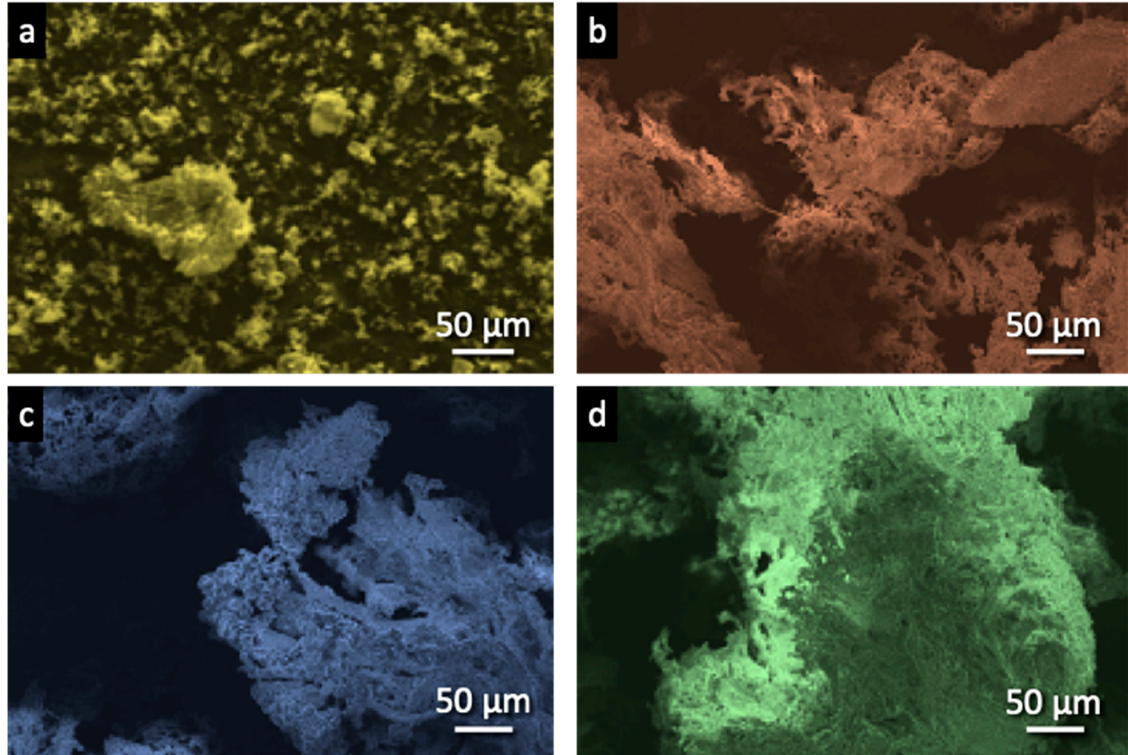
Figure 6. Activated carbon samples derived from ( a ) sucrose, ( b ) orange peels, ( c ) tea stalks, and ( d ) kiwi peels.